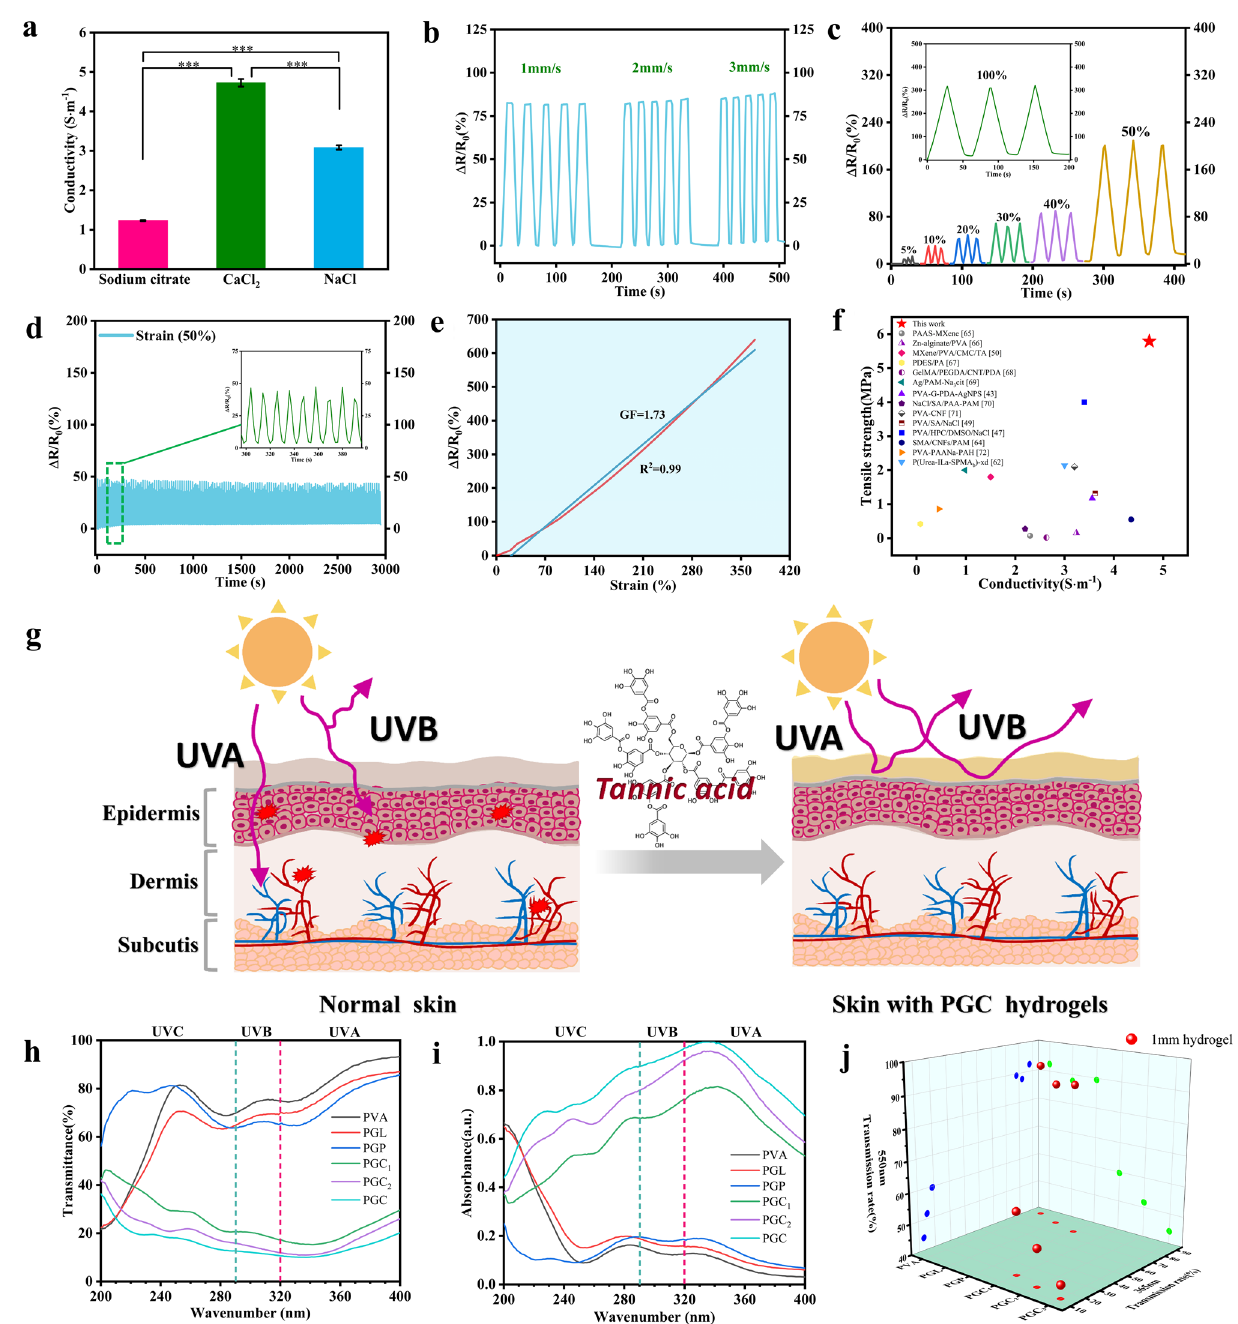
Fig. 3 Conductivity and the UV shielding properties of PGC hydrogel. a Electrical conductivity of PGC hydrogels in different ionic solutions. b Cyclic stretching at different speeds. c Relative resistance changes under different cycling tensile strains at a fixed tensile speed of 2 mm s −1 . d PGC hydrogel’s antifatigue conductivity of tensile loading–unloading cycles in 3,000 s. e Gauge factor under the strain range of 0–370%. f Com- parison plots of the hydrogel in this article with other recently reported works by tensile strength versus conductivity. g UV absorption diagram of PGC hydrogel. h UV–vis transmittance spectra, i UV–vis absorbance spectra, and j UV–vis transmittance at 550 and 365 nm of the PGC hydrogel with different TA contents. (*** p ≤